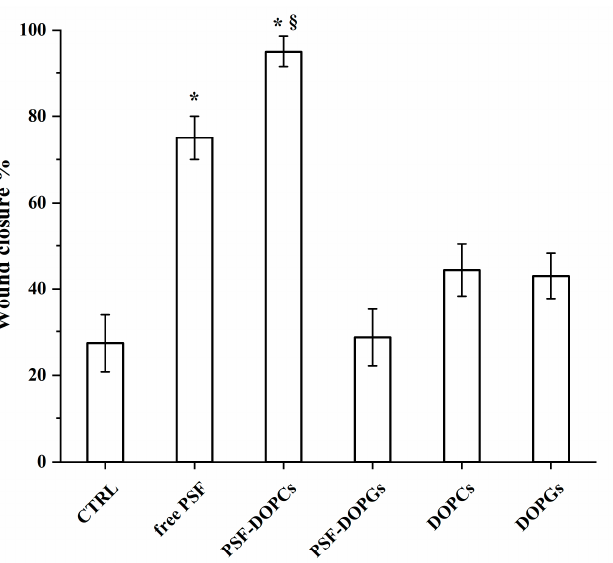
Figure 4. Wound-healing repair after free P. spinosa fruit extract (free PSF), extract-loaded vesicles (PSF-DOPCs and PSF-DOPGs) and empty vesicles (DOPCs and DOPGs) treatment. The graph shows the percentage of wound closure compared to untreated control (CTRL) after 48 h. The values reported are the mean ± SD of three independent experiments. * p < 0.05 vs. CTRL (Student’s t -test). § p < 0.05 vs. P. spinosa extract.